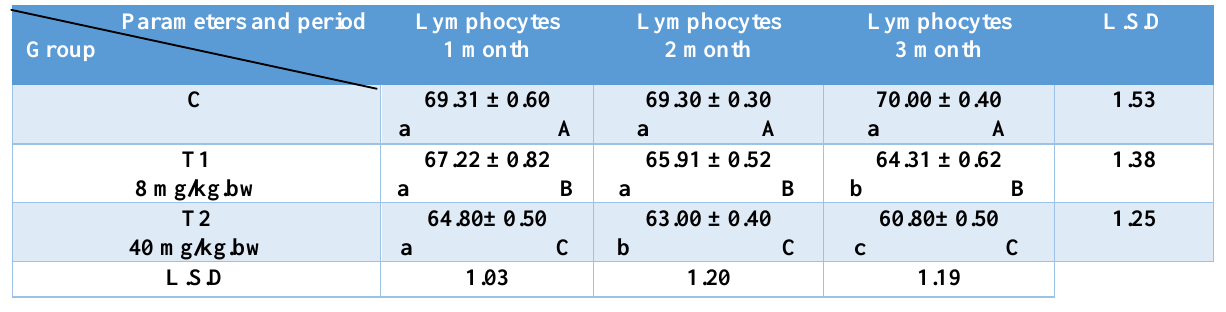
Table, 6: Values of Lymphocytes (%) in blood of rats treated with different doses of CuSO4.5H2O